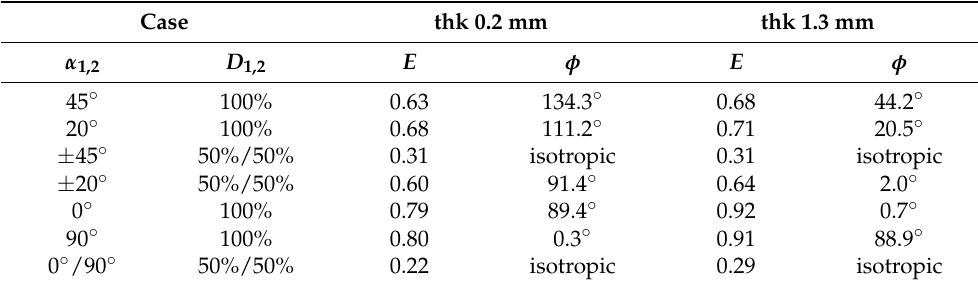
Figure 4. Isocurve fluence maps from simulation set S 1 : ( a ) α 1 = 45 ◦ , ( b ) α 1 = 20 ◦ , ( c ) α 1,2 = ± 45 ◦ , ( d ) α 1,2 = ± 20 ◦ , ( e ) α 1 = 0 ◦ , ( f ) α 1 = 90 ◦ and ( g ) α 1,2 = 0 ◦ /90 ◦ . Table 4. Table summarizing the E and the φ parameters resulting from the S 1 simulations at different fiber distributions and thickness